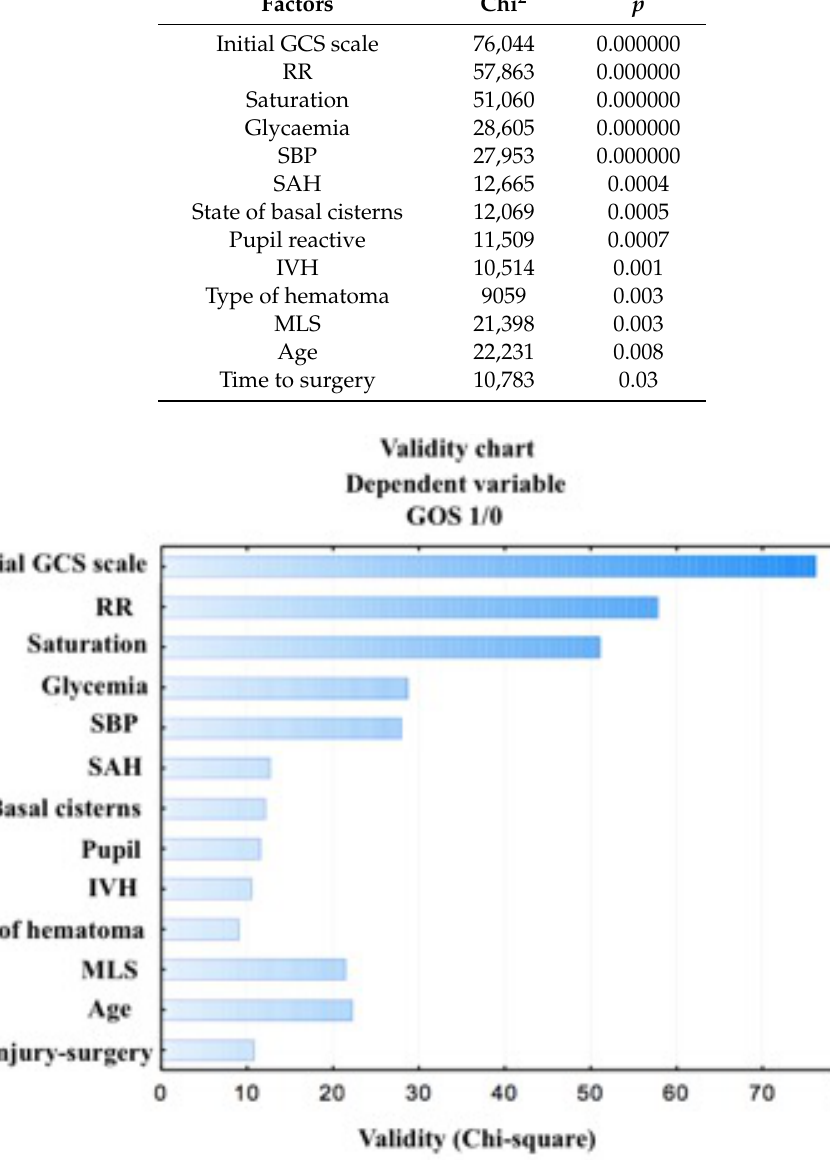
Figure 2. Dominant factors for the dependent variables of the outcome.